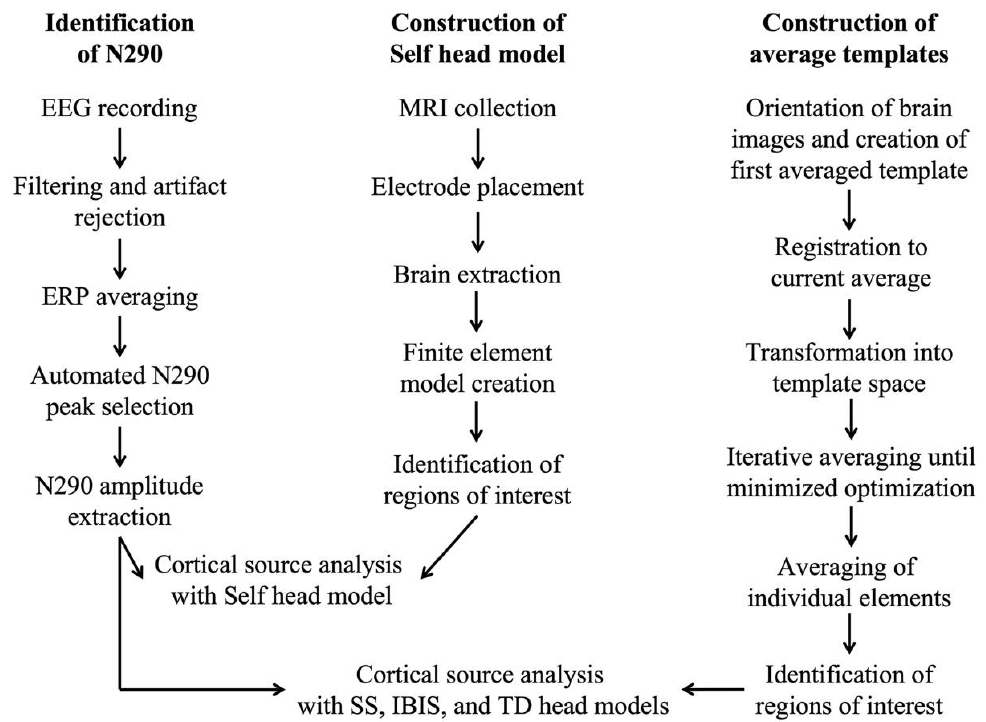
Figure 1. The workflow for the processing of electroencephalogram (EEG), event-related potential (ERP), and magnetic resonance imaging (MRI) data is presented, highlighting major steps in the processing stream. The “Construction of Self head model” stream was used for cortical source analysis of the N290 with the participant’s own MRI. The “Construction of average template” stream was used for cortical source of the N290 with the Infant Brain Imaging Study (IBIS), study-specific (SS), and typically developing (TD; i.e., 12-mo-TD, 12-yr-TD, and Adult-TD) averaged head models.